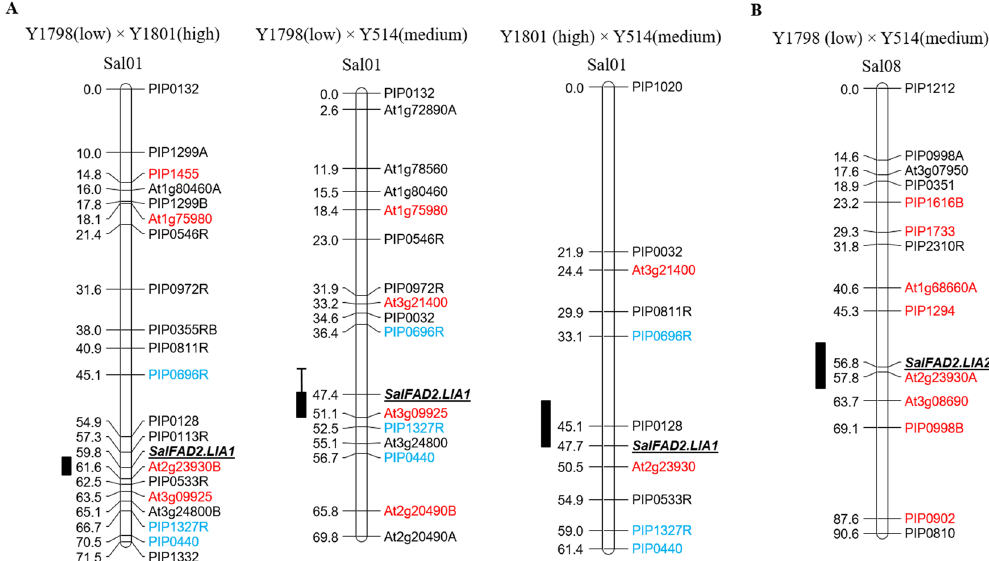
Figure 1. Mapping QTLs controlling C18:2 content in yellow mustard. ( A ) The C18:2 QTL in Sal01 is located between PIP0113R and At2g23930B in Y1798 (low) × Y1801 (high), between PIP0696R and At3g09925 in Y1798 (low) × Y514 (medium), and between PIP0696R and At2g23930 in Y1801 (high) × Y514 (medium). ( B ) The C18:2 QTL in Sal08 is located between PIP1294 and At3g08690 in Y1798 (low) × Y514 (medium). 1-LOD and 2-LOD supporting intervals of each C18:2 QTL were marked by thick and thin bars, respectively. Markers in blue font were detected in all three crosses. Markers in red font were mapped to the same linkage groups as reported by Javidfar and Cheng (2013) 31 . The SalFAD2 . LIA1 and SalFAD2 . LIA2 genes co-localized with their C18:2 QTL peaks in the linkage groups Sal01 and Sal08,